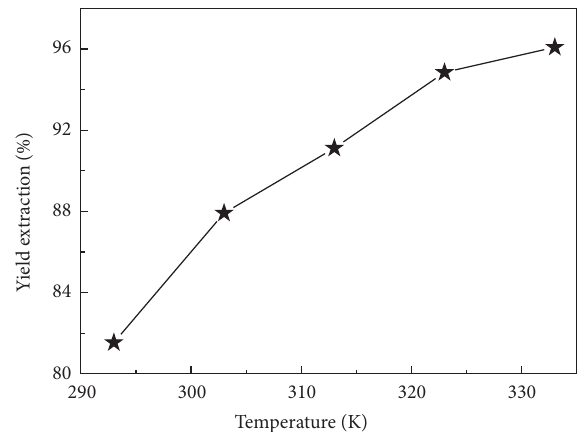
F 10: Effect of temperature on the yield extraction of Cd(II) by = 1.0mmol , m = 0.030g, V = 5mL, the functionalized resin. C initial pH = 5.0, and equilibrium time = 0